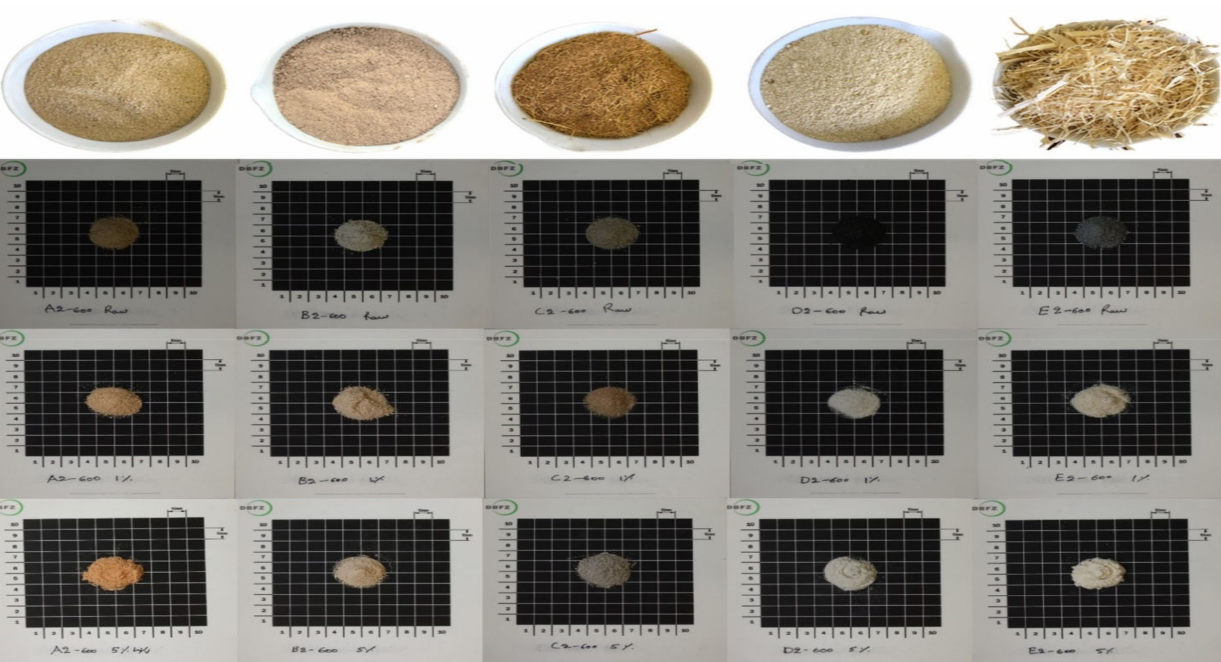
Figure 5. Visual appearances of thermally produced ashes of the raw and the acid-leached biomass fuels at 600 ◦ C. First row from the top : untreated biomass fuels; second row : ashes of untreated biomass fuels; third row : ashes of 1 w / v % biomass fuels, and; last row : ashes of 5 w / v % biomass fuels. From left to right, biomass fuels and ashes of cassava peelings (CasP), yam peelings (YamP), coconut husk (CocH), corncobs (CorC) and cornhusk (CorH) generated at 600 ◦ C for 2